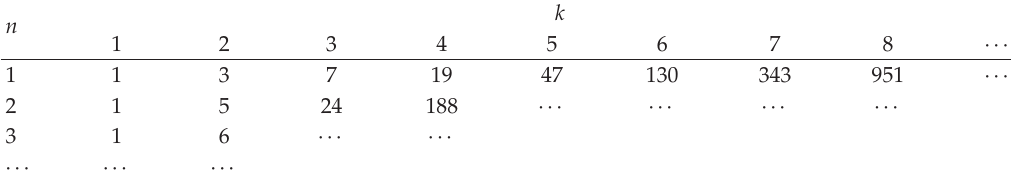
Table 1: Number of nonisomorphic associative mono- n -ary algebras with k elements. n